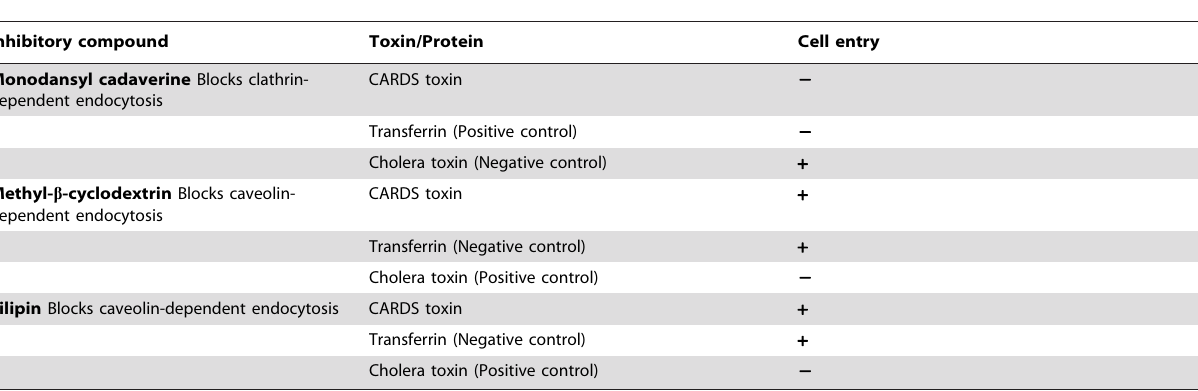
Table 1. Effects of endocytic pathway inhibitors on cell entry of rCARDS